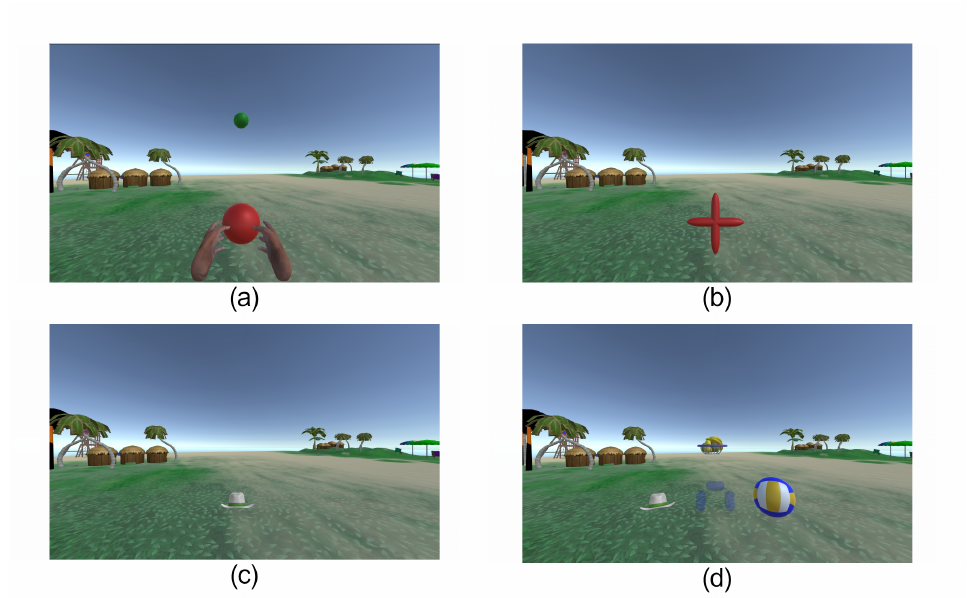
Figure 3. Steps in the execution of the object recognition task. ( a ) First, a red ball appeared until the participant centered their view and pressed the joystick button. ( b ) The fixation cross appeared for two seconds. ( c ) An object appeared at the location indicated by the fixation cross. ( d ) Finally, three objects appeared, and the participant was asked to quickly select the object that had just been displayed by using the controller’s